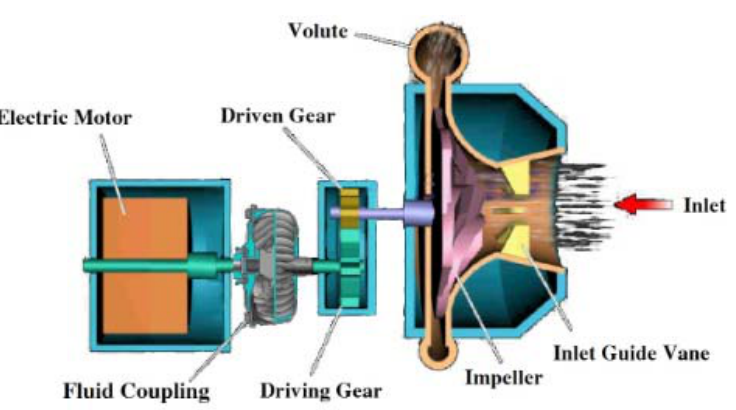
Figure 8. Schematic of the test-rig.